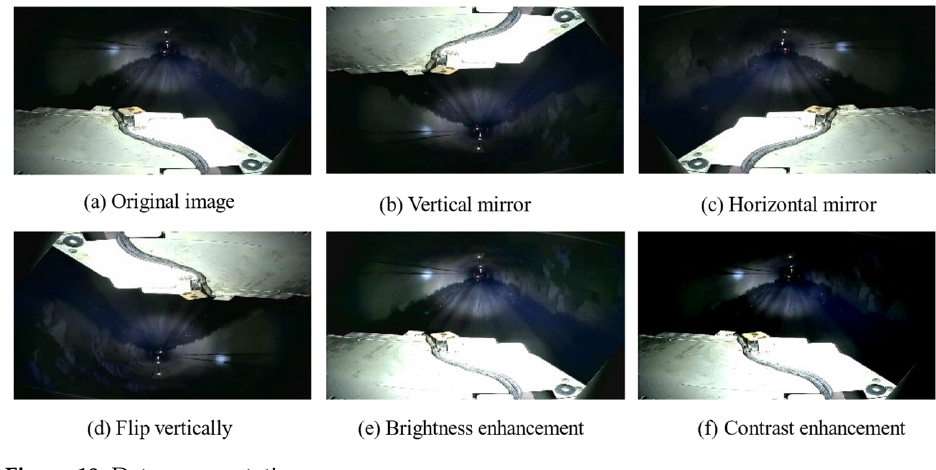
Figure 10. Data augmentation.